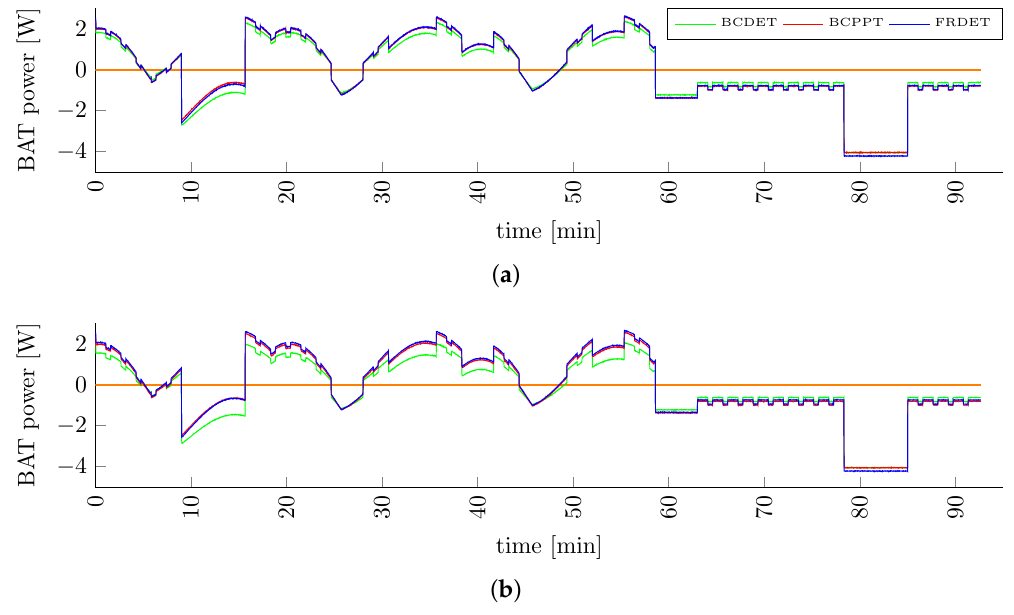
Figure 14. BAT power balance for initial OCV of: ( a ) 4.0V; ( b )